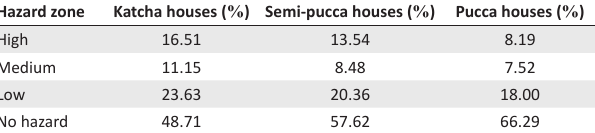
TABLE 6: Vulnerability of human settlement according to flood hazards zone. Hazard zone